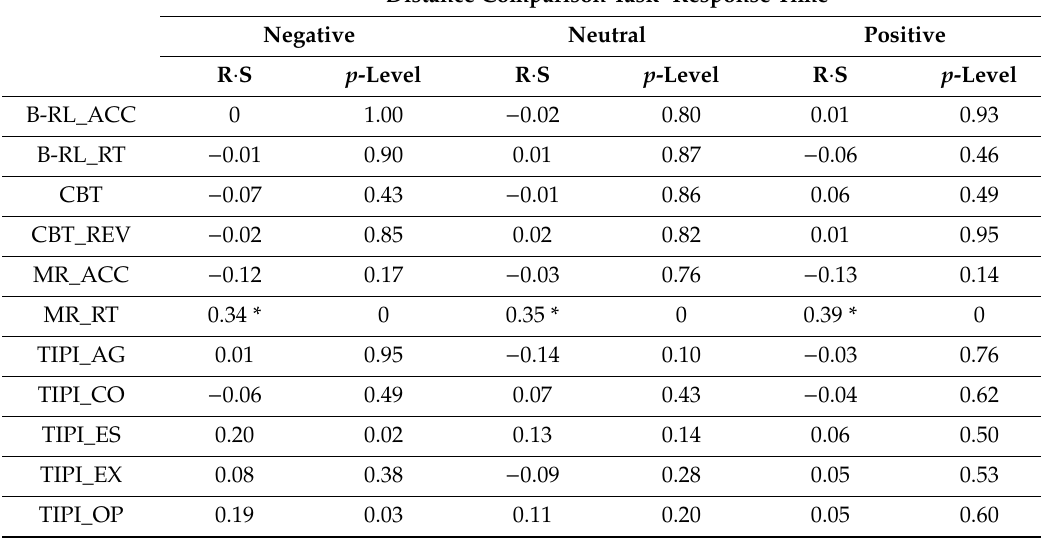
Table 4. The table shows Spearman’s (R) correlation indexes (and the corresponding p -levels) between cognitive tasks, personality traits, and accuracy at the distance comparison task. The asterisk (*) indicates the correlations that survived to the correction for multiple